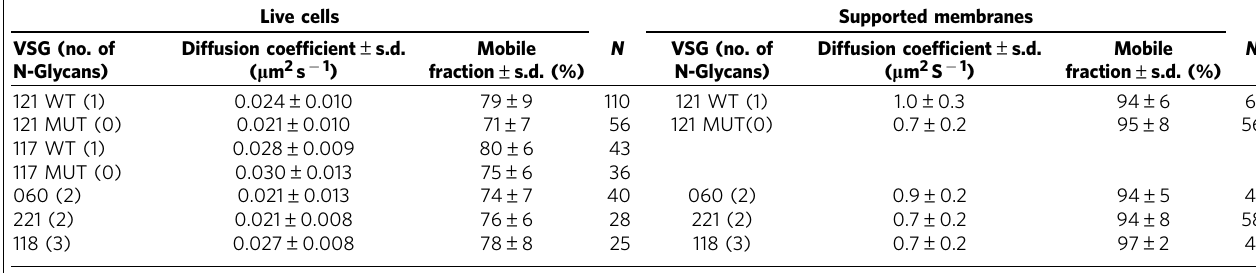
Table 1 | Diffusion of various VSGs on live cells and on supported